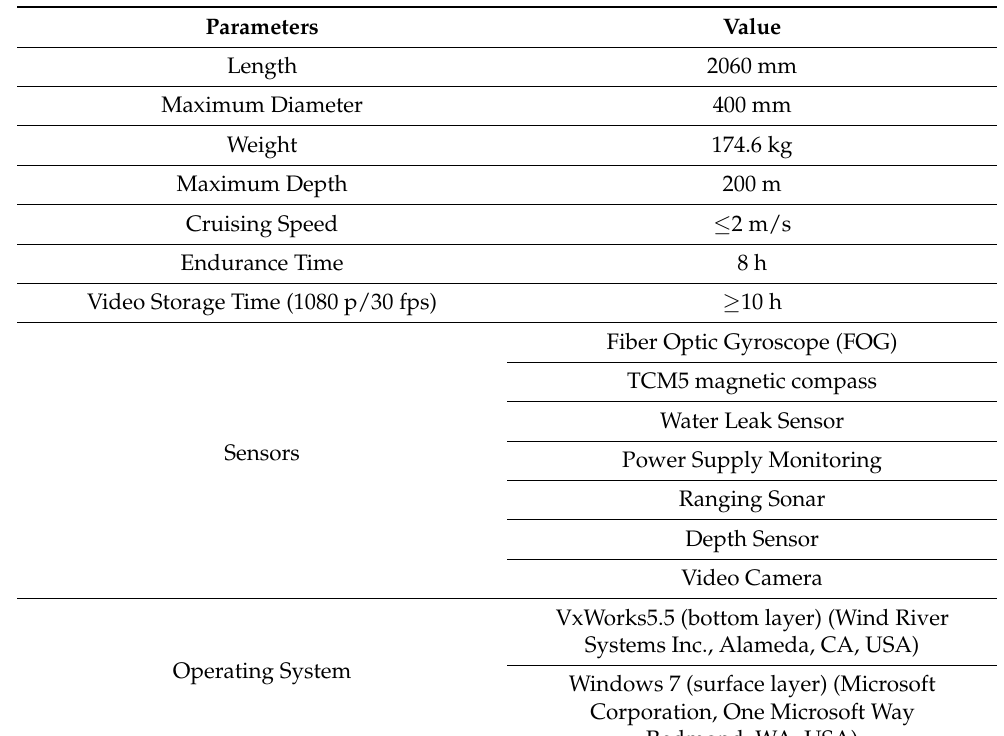
Table 1. The parameters of the